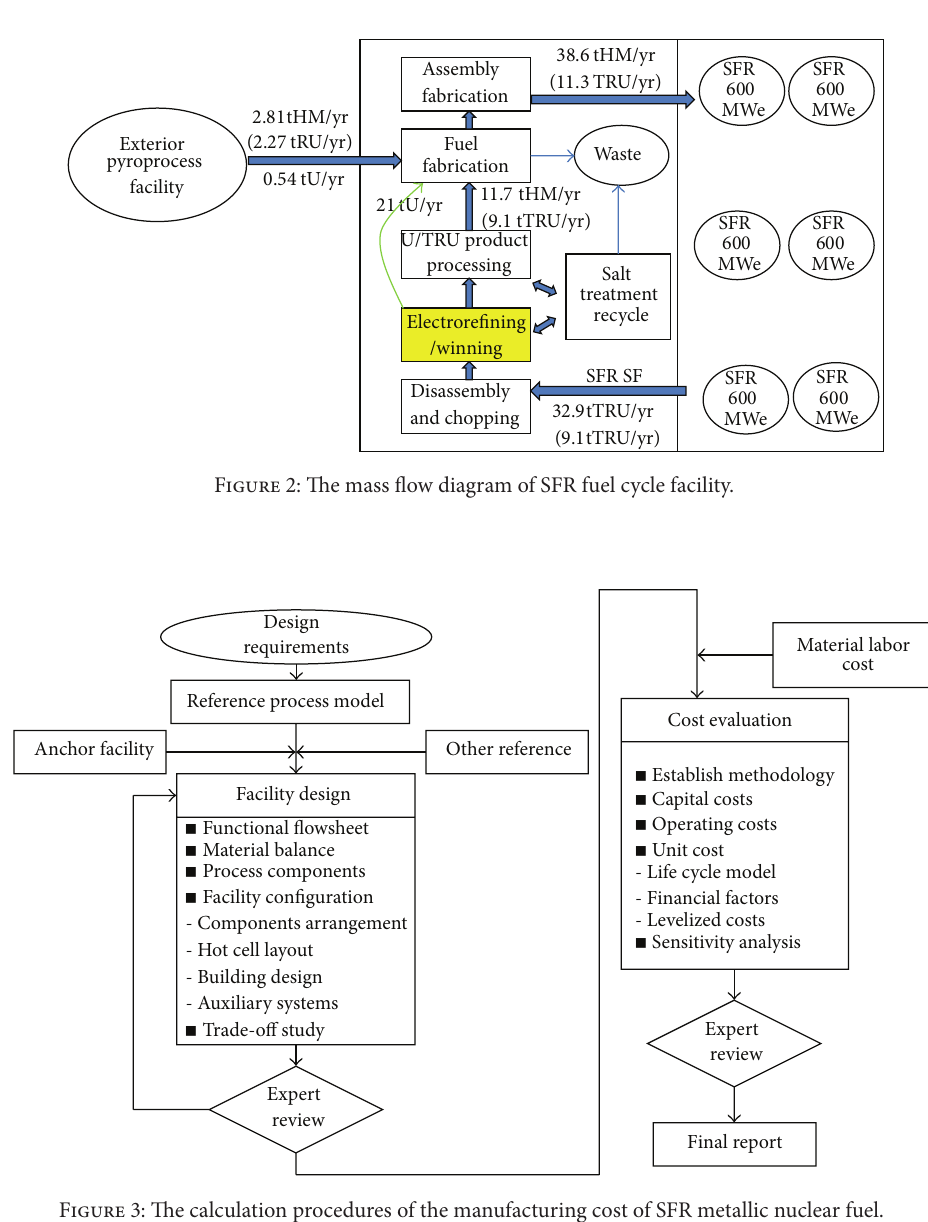
Figure 3: The calculation procedures of the manufacturing cost of SFR metallic nuclear